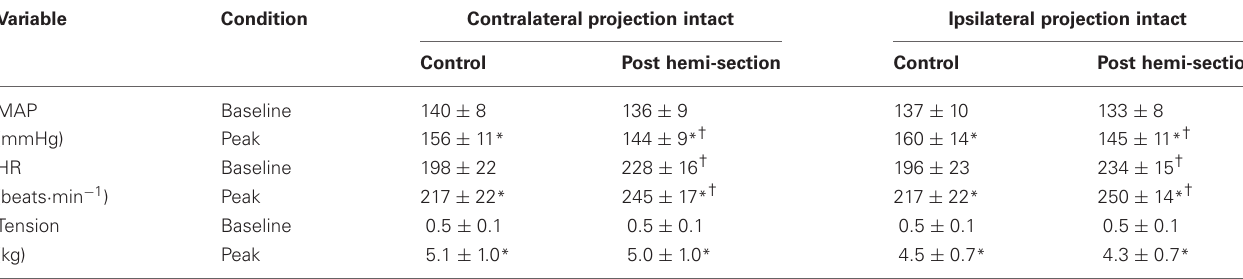
Table 1 | Cardiovascular responses to contraction before and after hemi-section of the spinal cord. Variable Condition Contralateral projection intact Ipsilateral projection intact Control Post hemi-section Control Post